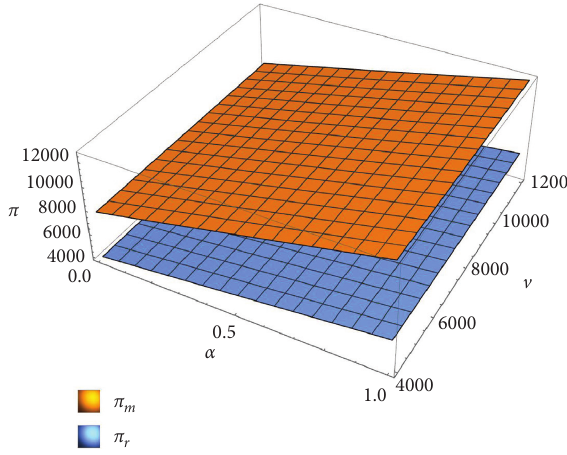
Figure 8: The changes in profits with v and α